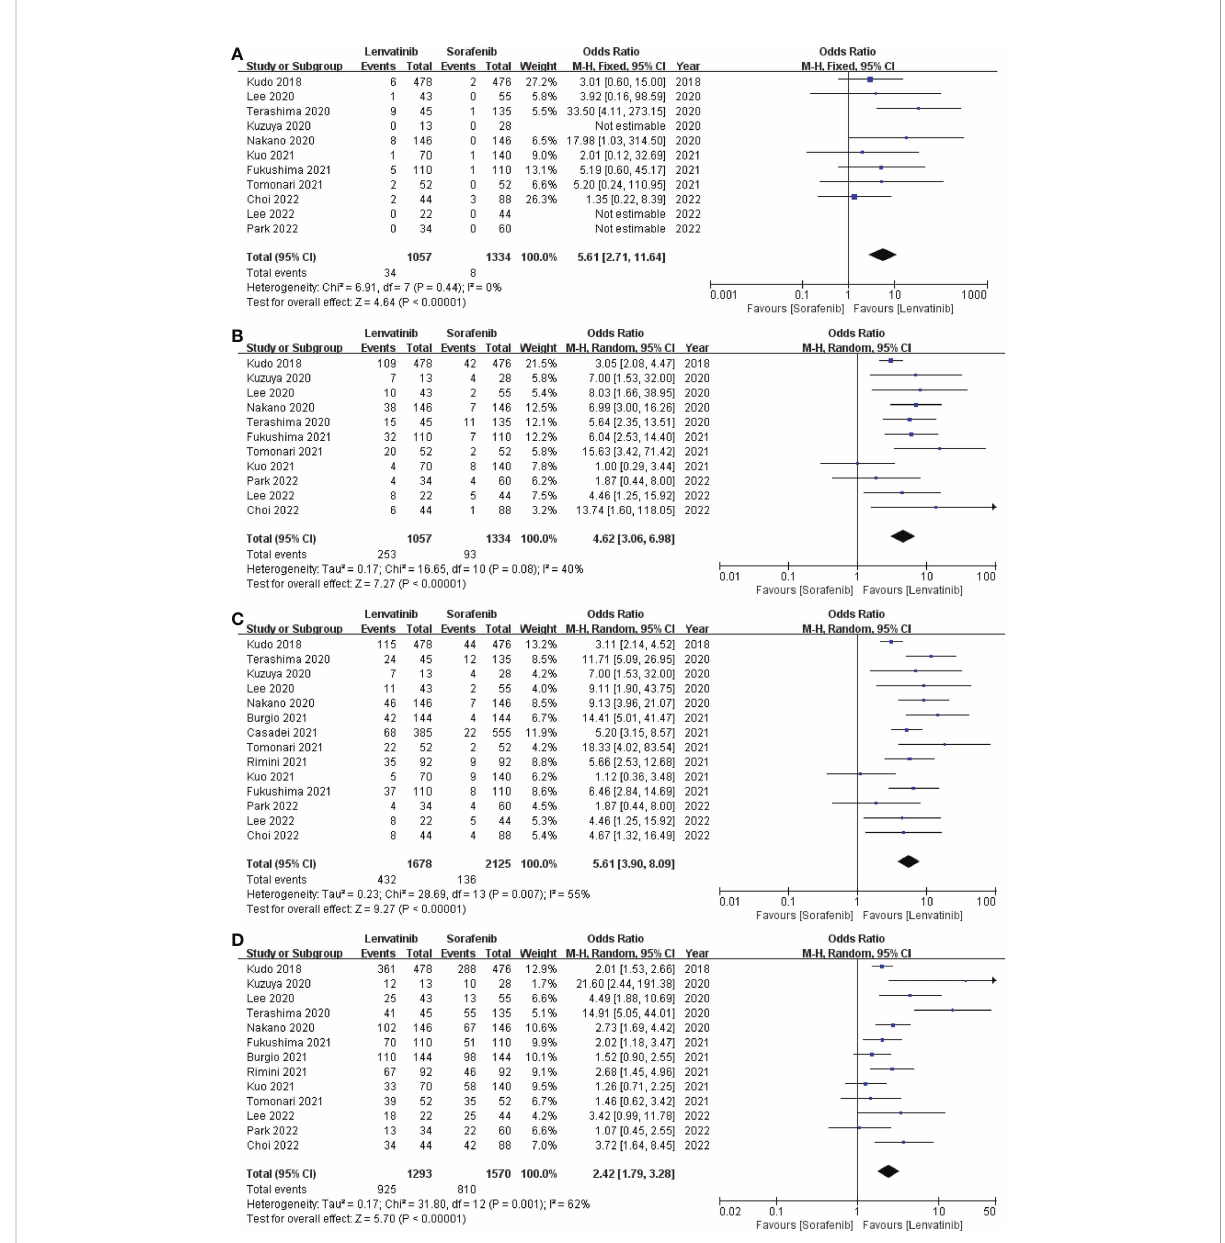
FIGURE 5 Forest plot on CR (A) , PR (B) , ORR (C) , and DCR (D) . CR, complete response; PR, partial response; ORR, objective response rate; DCR, disease control